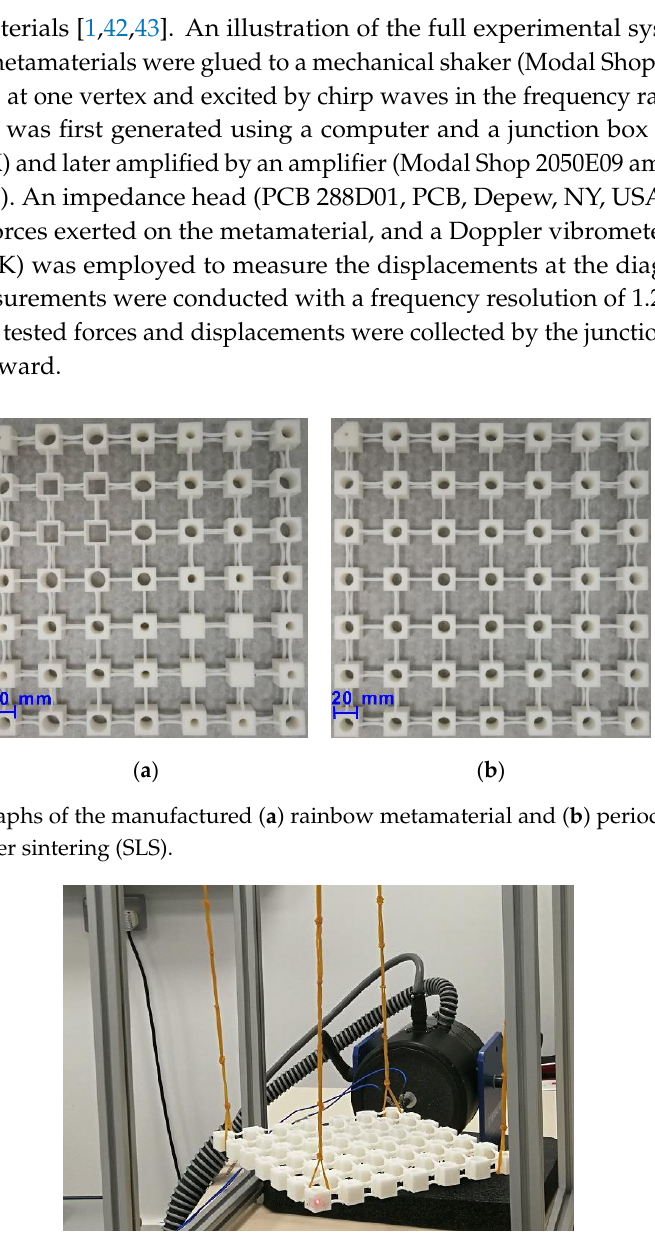
Figure 6. Photograph of the experimental setup for the frequency response functions (FRFs) test of the 2D metamaterial.